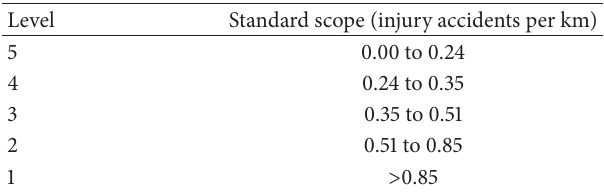
Table 1: RIOH standard of safety levels. Table 2: Basic road condition of general